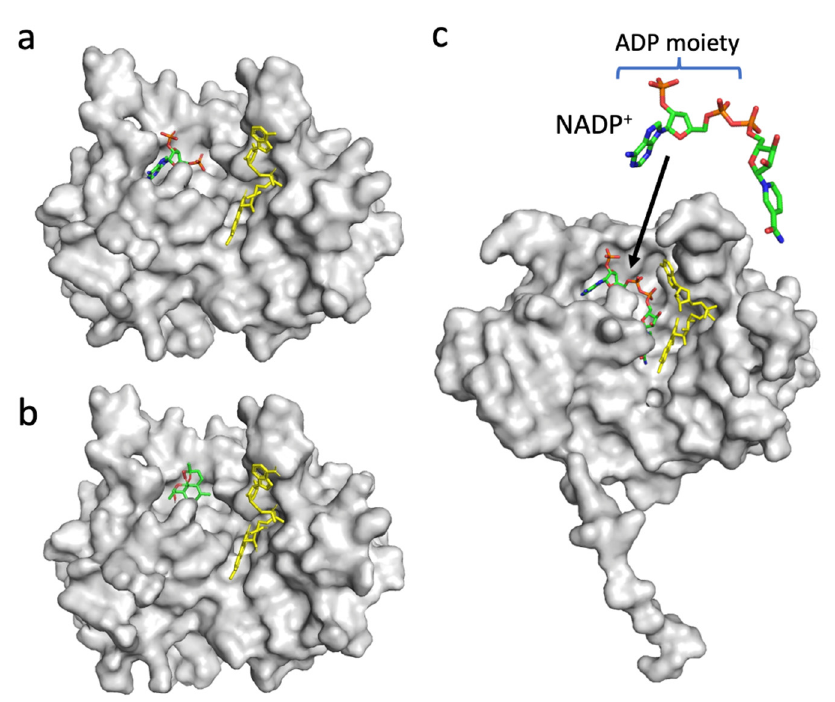
Figure 6. Structures of PfFNR complexed with 2 ′ 5 ′ ADP (accession code 2OK7) ( a ), PfFNR docked with DHA in silico ( b ), and Pea FNR (Tyr308Ser) mutant complexed with NADP + (accession code 1QFZ) ( c ). The FAD moiety is shown as a yellow-colored stick model ( a – c ), and 2 ′ 5 ′ ADP ( a ), DHA ( b ), and NADP + ( c ) are shown as stick models. ( b ) The docking structure obtained with the lowest binding energy ( Δ G) is shown.